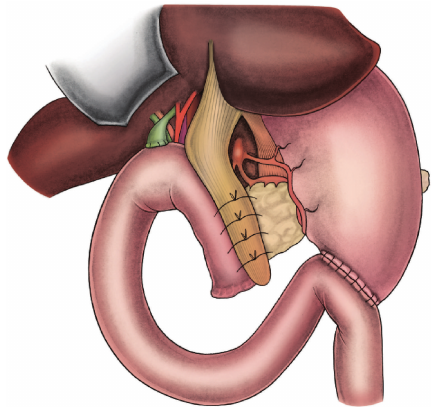
Figure 1: Anastomotic dehiscence and leakage from the right side of the pancreaticojejunal anastomosis.